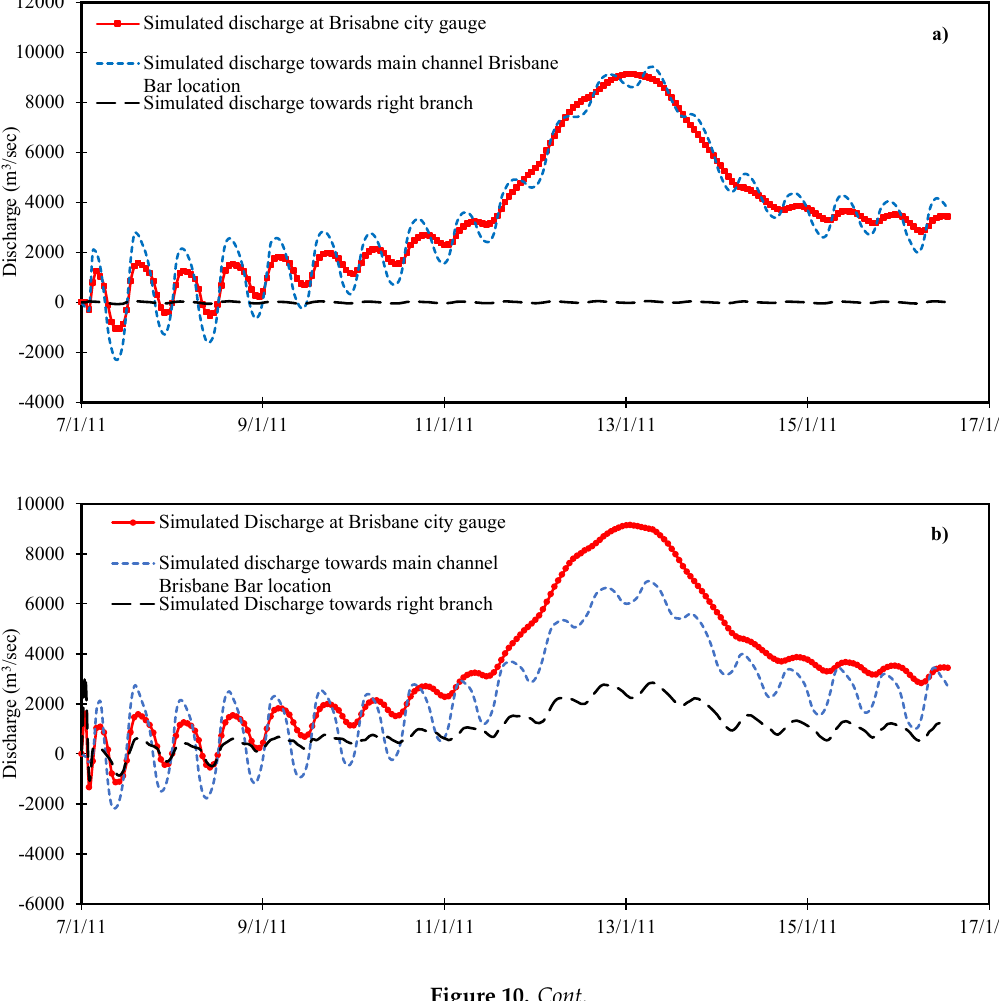
Figure 10. ( a ) Flow distribution at BRE under normal condition; ( b ) after widening of the right channel; ( c ) Comparison of water levels at the Brisbane city gauge before and after widening of the right channel. 4.4. Influence of CR on the BRE Flood Adaptation The modelled ability of the CR to modify flood water levels in the BRE for the 2011 floods is analysed in the following section. Two different cases of the Brisbane River flow were considered for